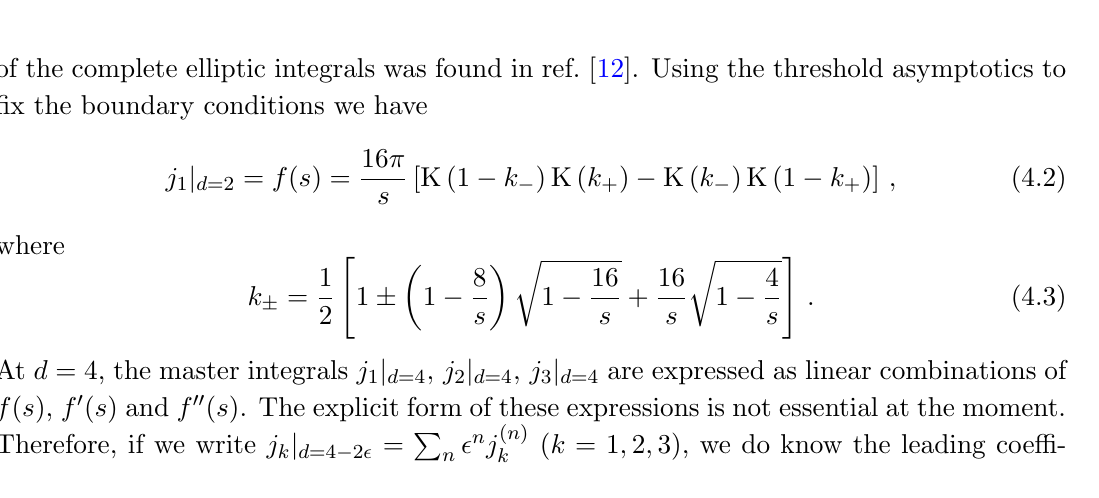
Figure 3 . The cut master integrals. The solid (dashed) lines denote massive (massless) propagators, thin vertical line corresponds to the